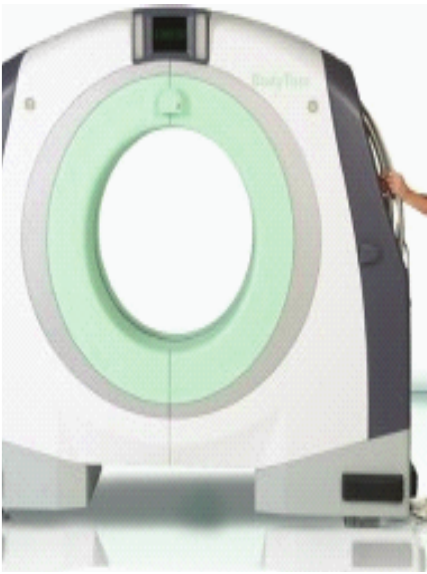
Figure 7: The “Bodytom” portable full body CT scanner. Courtesy of Neurologica.